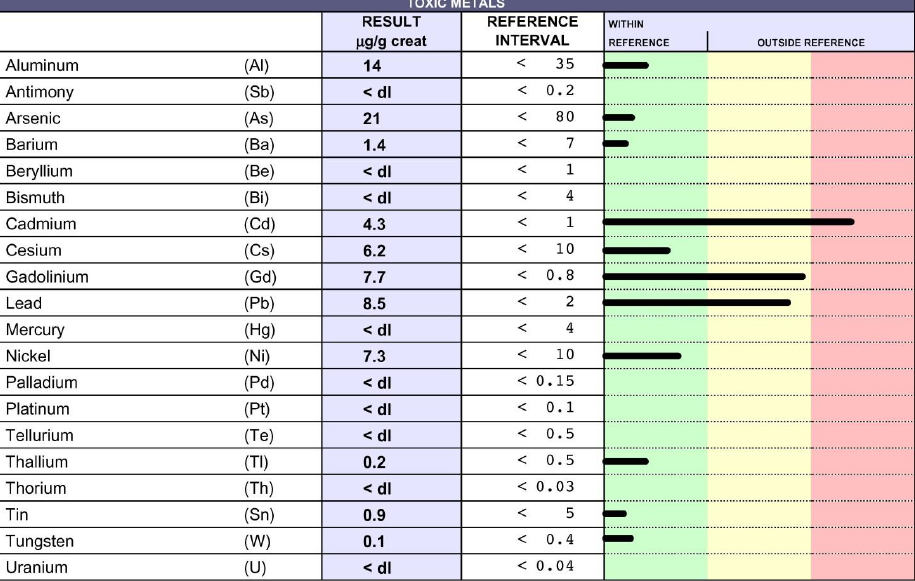
Figure 4. TM levels decreased after EDTA therapy: The presence of TMs in the urine samples of IM following 9 months of therapy with EDTA was evaluated using inductively coupled plasma mass spectrometry. Cd, Pb and, in particular, Gd levels decreased in comparison with those detected before therapy (Figure